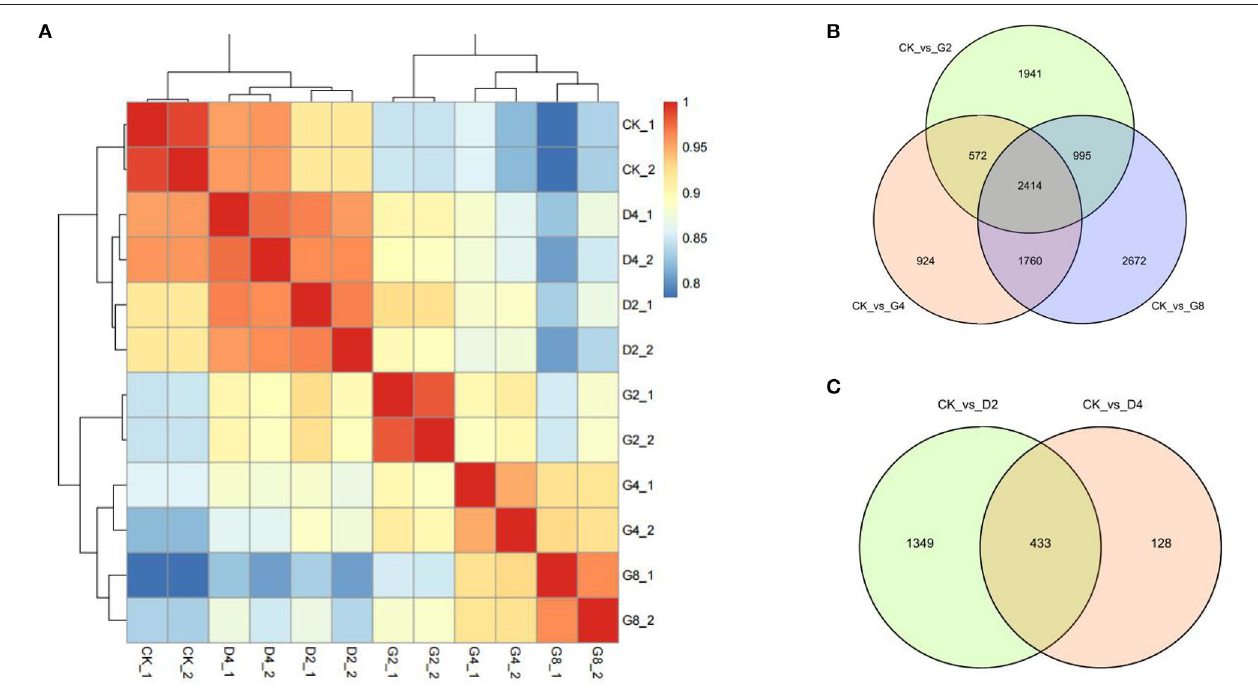
FIGURE 1 | RNA-seq of moso bamboo leaves under dehydration and cold treatments. (A) Correlation and clustering of each sample. (B,C) Venn diagram of differentially expressed genes (DEGs) under two treatments. CK, control; D2 and D4 indicated 2h and 4h of cold treatment, and G2, G4, and G8 indicated 2h, 4h, and 8h of dehydration treatment,